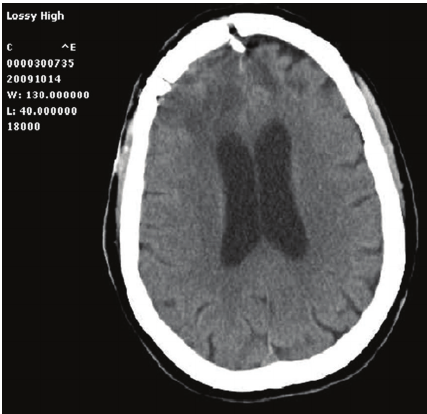
Figure 3: Axial CT scan few days after granuloma excision: note the dramatic but incomplete reduction of brain